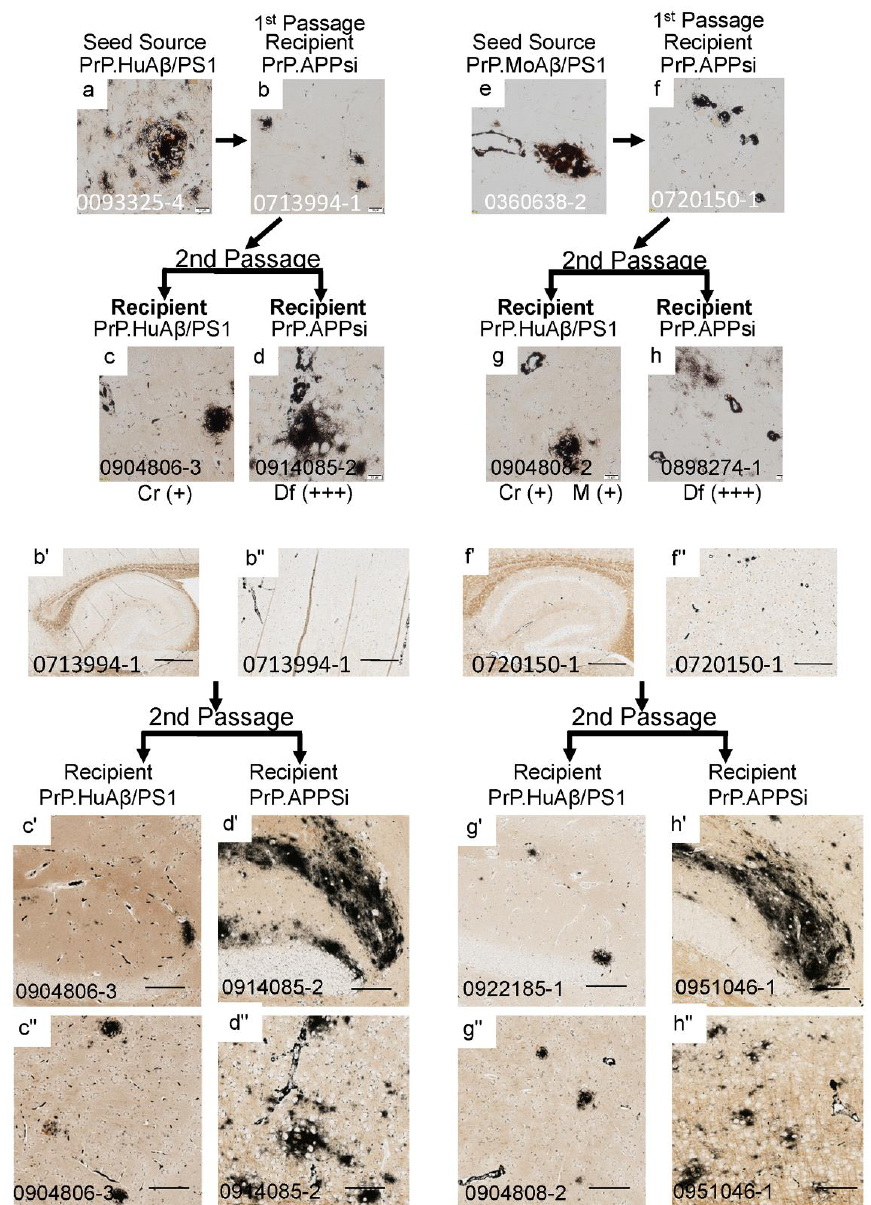
Figure 4. Serial passage of cored Aβ pathology through PrP.APPsi hosts. The upper panels show high- power images of Aβ deposit morphology from C -S silver staining in the brain of the seed source animal, the first passage recipients, and the second passage recipients. Aβ pathology was confirmed by Aβ immunostaining ( Figure S4). The criteria for scoring pathology burden were the same as described in the legend of Figure 1. The lower panels show low power views of the seeded animals. Details of animal numbers for each injection are provided in Table 3 and Table S2. ( a ) Image from the cortex of the original s eed source PrP.HuAβ/PS1 animal. ( b , bʹ , bʹʹ ) Images from the recipi- ent PrP.APPsi mouse used as host for Passage 1 (aged 12 months before harvest). ( c , cʹ , cʹʹ , d , dʹ , dʹʹ ) Representative images of brain from recipients seeded with first passage brain from PrP.APPsi mice. ( e ) Image from the cortex of the original seed source PrP.MoAβ/PS1 animal. ( f , fʹ , fʹʹ ) Images from the recipient PrP.APPsi mouse used as host for Passage 1 (aged 12 months before harvest). ( g , gʹ , gʹʹ , h , hʹ , hʹʹ ) Representative images of brain from recipients seeded with first passage brain from PrP.APPsi mice. In the upper panel, below each row of images from the 2nd passage seeded animals, there is information on pathological rating (Df = diffuse; Cr = cored) and relative severity, using the